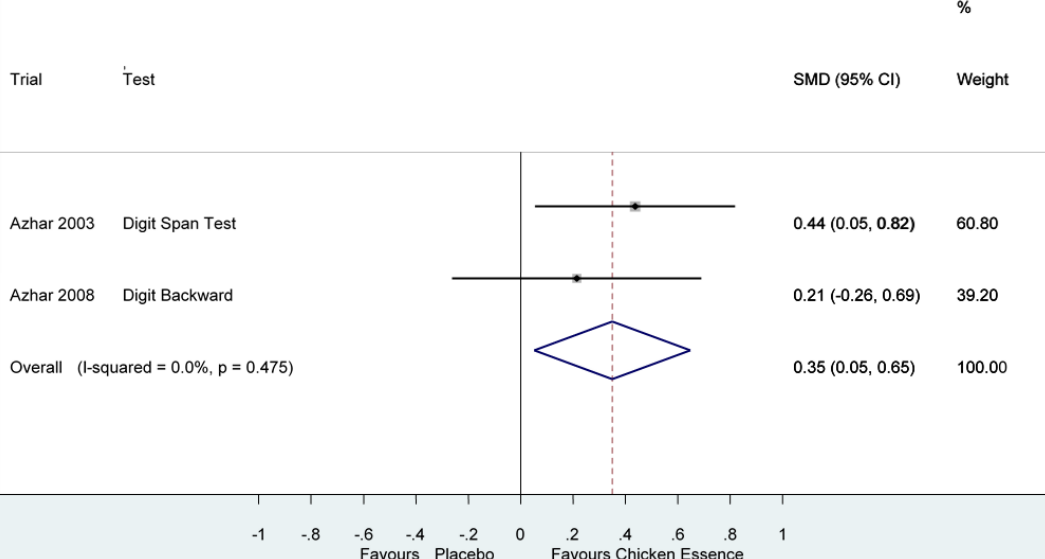
Figure D1. Pooled effect estimate of score of longest list of digits remembered of executive function tests (with Azhar’s test removed [2]).